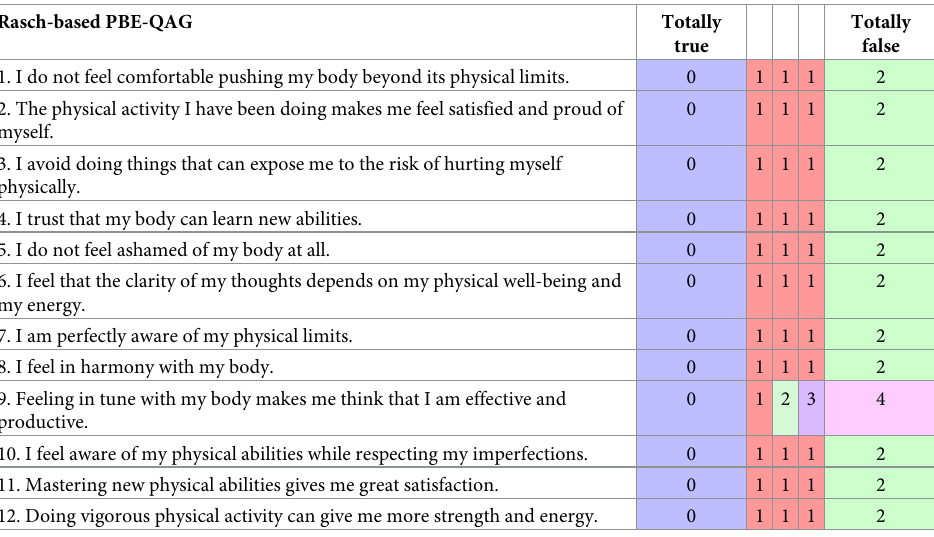
Table 4. Revised Rasch-based PBE-QAG for adults with chronic